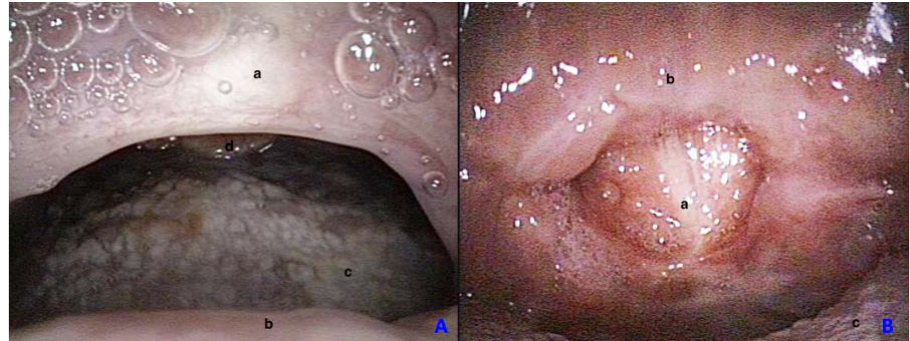
Figure 3. Post-operative control at 6 months from a nasopharyngeal view ( A ) and from an oral view ( B ). a—posterior pharyngeal wall, b—soft palate, c—tongue, d—epiglottis. ( B ). a—posterior pharyngeal wall, b—soft palate, c—tongue,